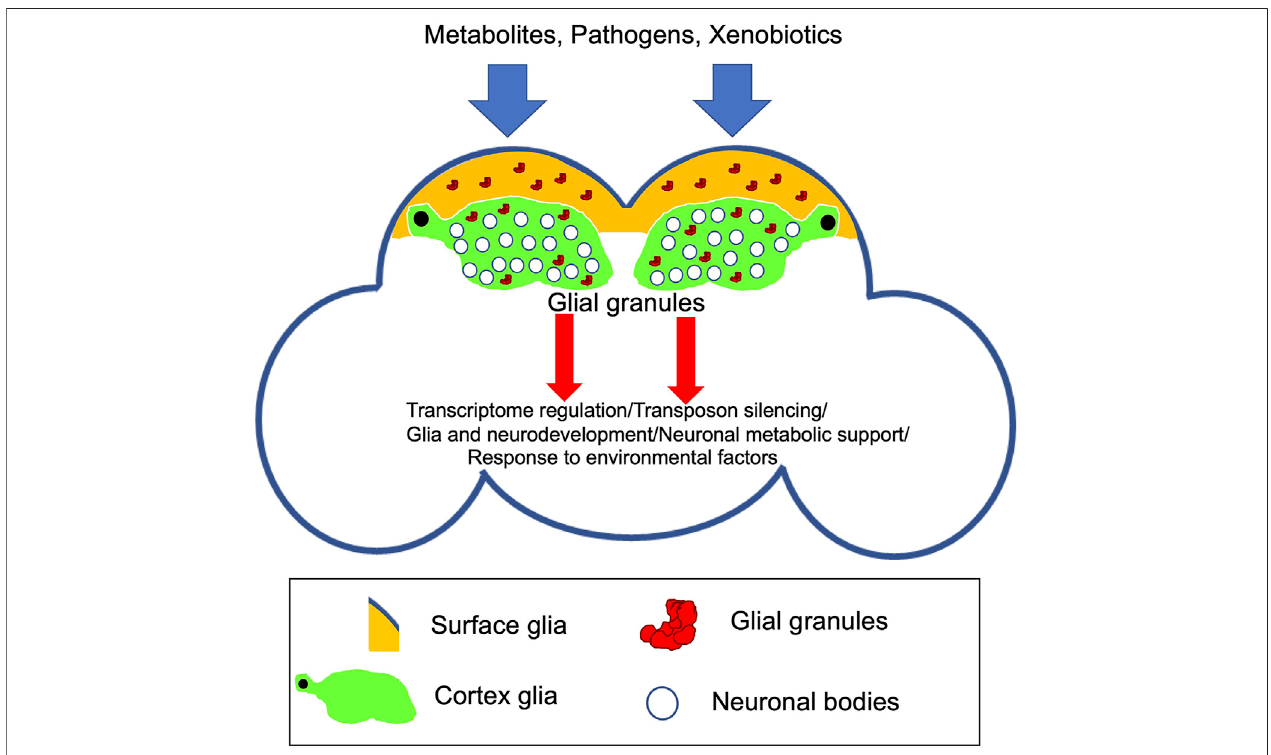
FIGURE 2 | Schematic of the adult Drosophila brain indicating novel glial granules assembled in surface and cortex glia. Recent evidence points to the function of these granules in transcriptome regulation and silencing of transposable elements in the Drosophila brain (Tindell et al., 2020). Future research will test whether glial granules are involved in speci fi c aspects of brain development and function including neuronal survival and metabolic support, behavior, and response to external/ environmental factors.